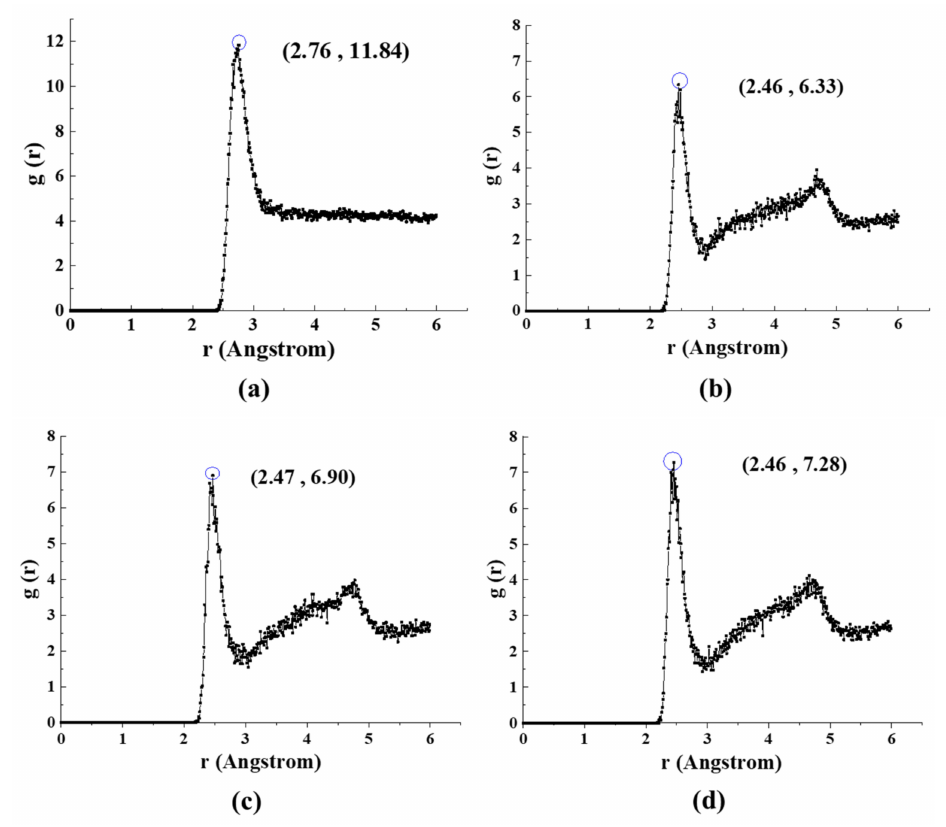
Figure 12. Radial distribution functions of SDS head groups and water molecules in different cationic foam systems. ( a ) SDS, ( b ) SDS with 50 g/L CaCl 2 , ( c ) SDS with 50 g/L MgCl 2 , and ( d ) SDS with 50 g/L NaCl.